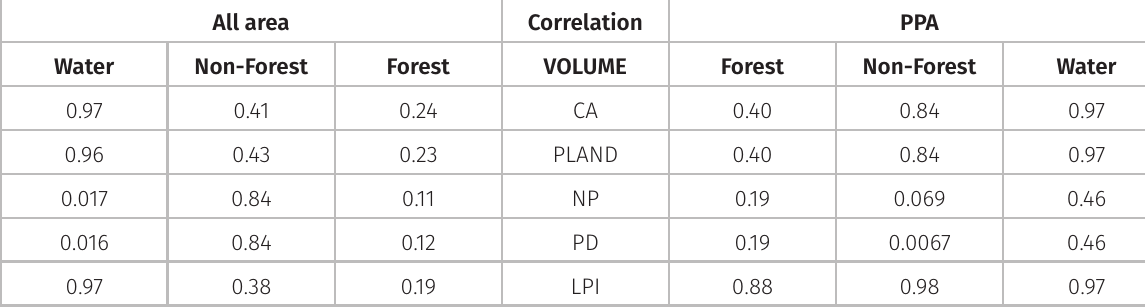
Table III. Correlation between Serra Azul reservoir volume and configuration landscape metrics throughout the study region and in the permanent preservation